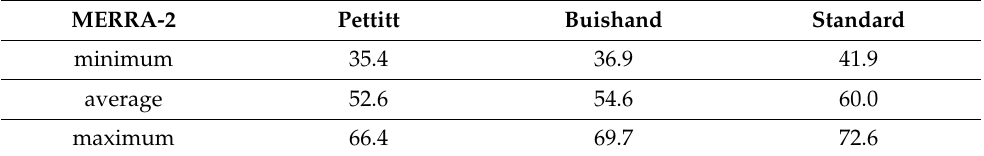
Table 2. Minimal, average and maximal share of discontinuities to all grids in percentage from all months from MERRA-2 for the Pettitt test, the Buishand test and the Standard Normal Homogeneity test. MERRA-2